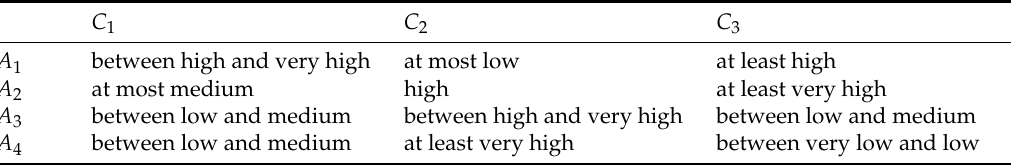
Table 1. The linguistic expressions provided by the